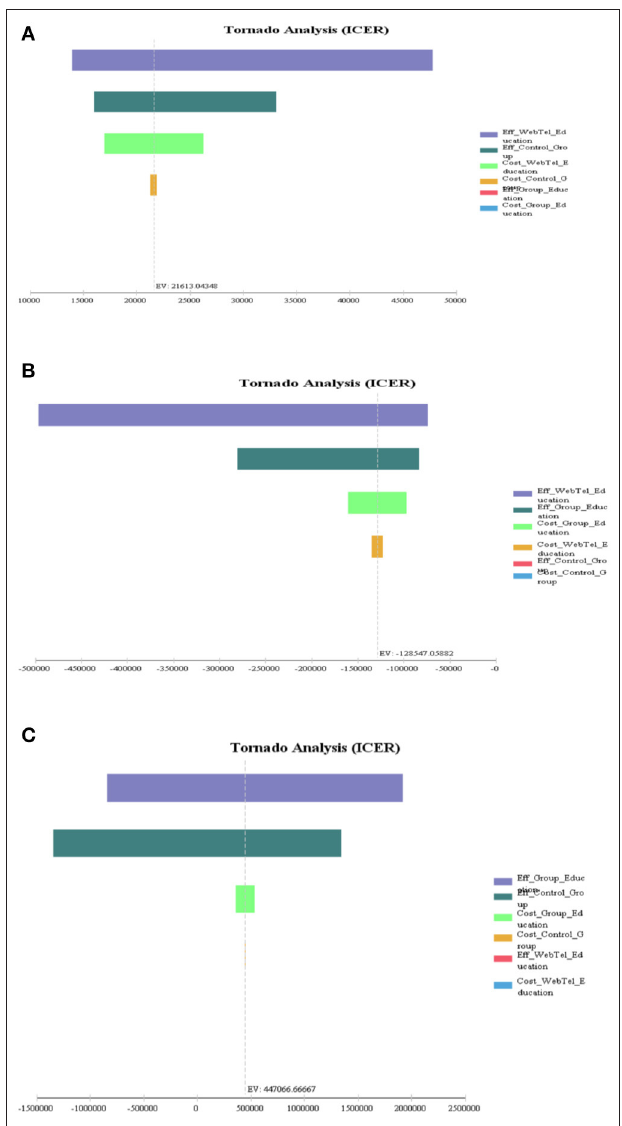
FIGURE 3 | One-way sensitivity analysis and tornado diagram of incremental cost-effectiveness ratio (ICER) comparisons among the three groups of patients with type 2 diabetes. (A) Web-Tel education vs. control group, (B) Web-Tel education vs. group education, and (C) group education vs. control